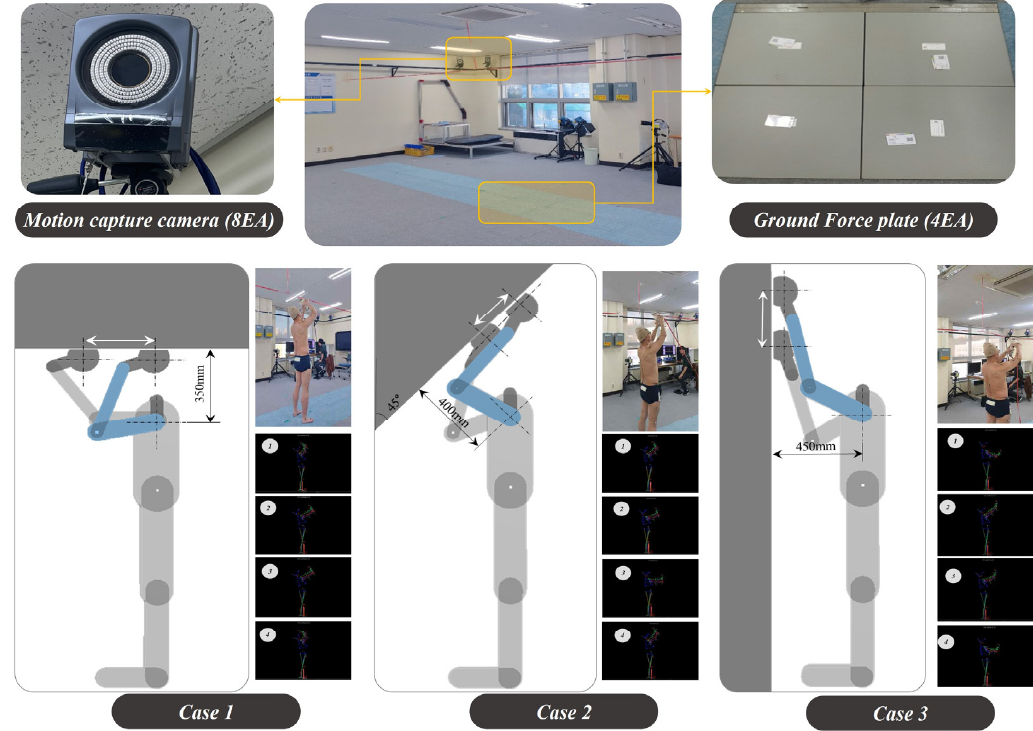
Figure 2. Motion capture device and experiment environment.